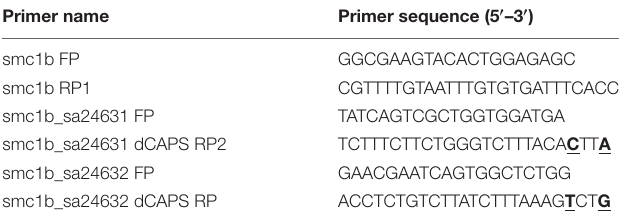
TABLE 2 | Genotyping